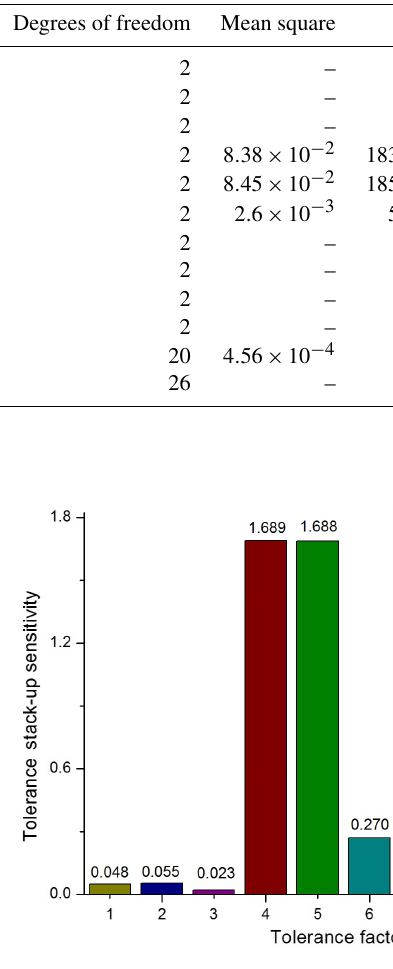
Figure 9. Tolerance stack-up sensitivities for the tolerance factors.